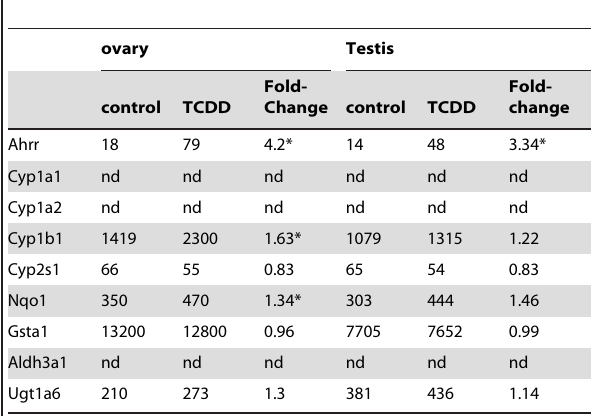
Table 5. Expression levels of classical genes targeted by